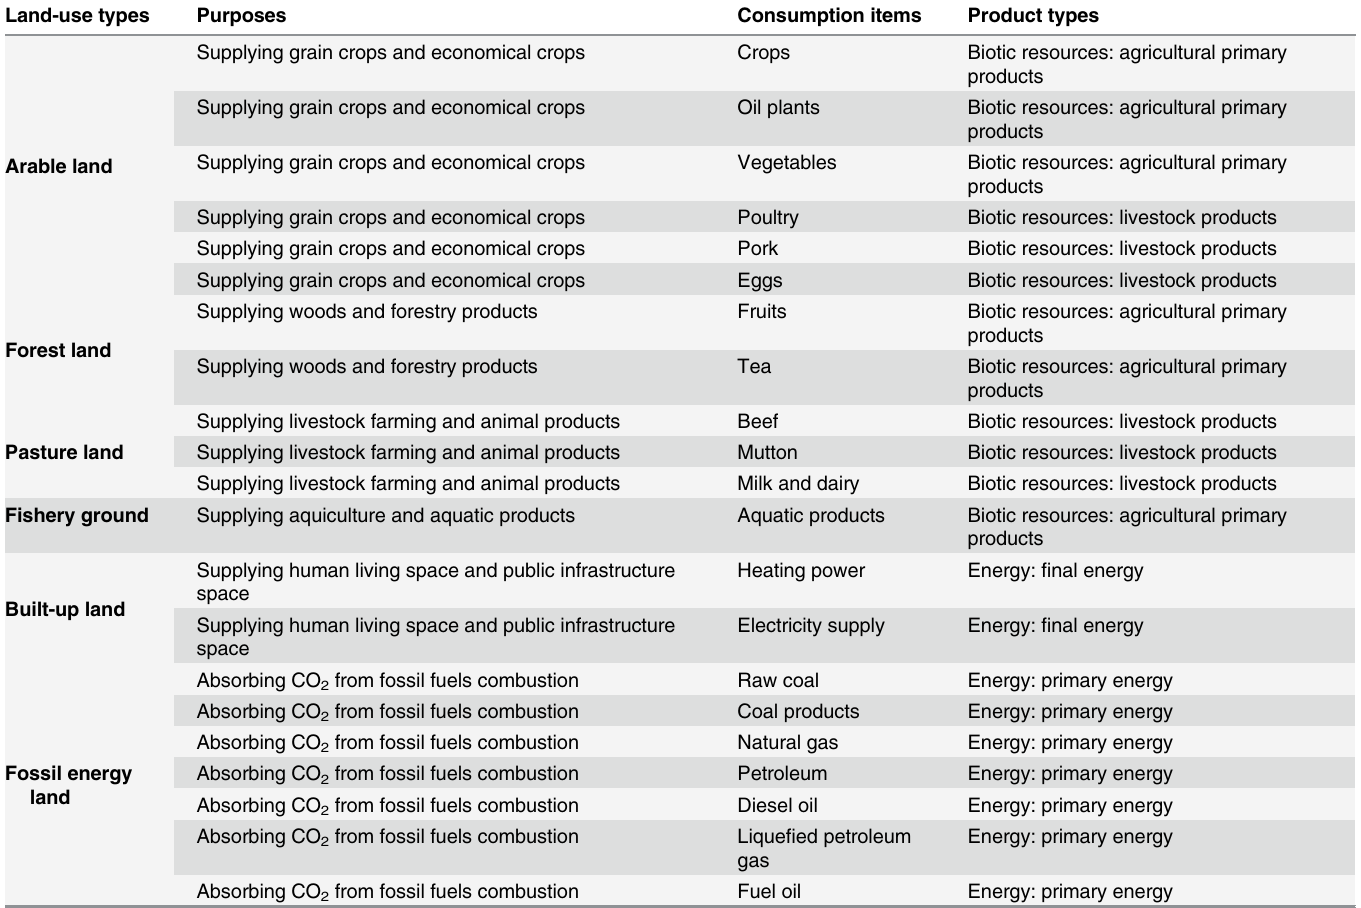
Table 2. Land-use classification and consumption